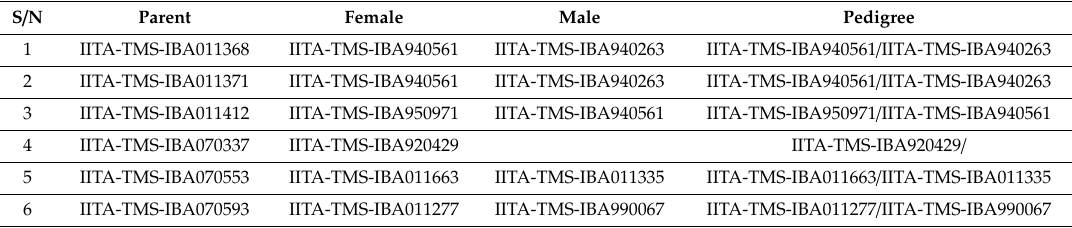
Table 1. Pedigree information of the six parents used in this study.